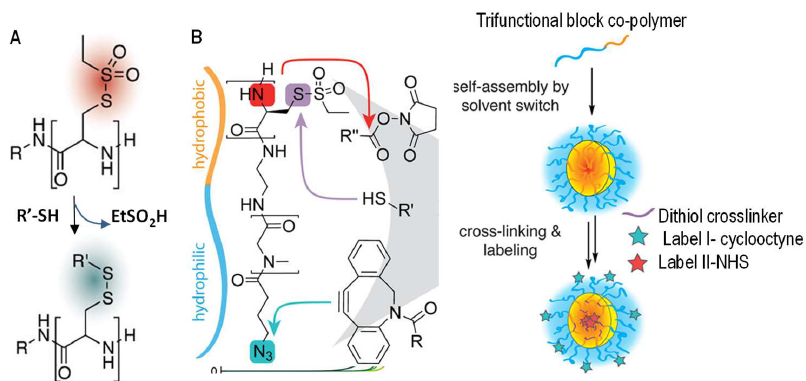
Figure 7. Thiol-disulfide exchange between thiols and thiolsulfonates for the functionalization ( A ) and chemical crosslinking ( B ) of thiol-functionalized polymers. In both cases the formed disulfide links are redox-responsive. This exchange reaction in ( B ) was shown to be orthogonal to ester formation and 1,3-dipolar cyclic addition used for labeling the gel particles with dyes. Images are modified with permission from [44]. Copyright 2017 ACS.